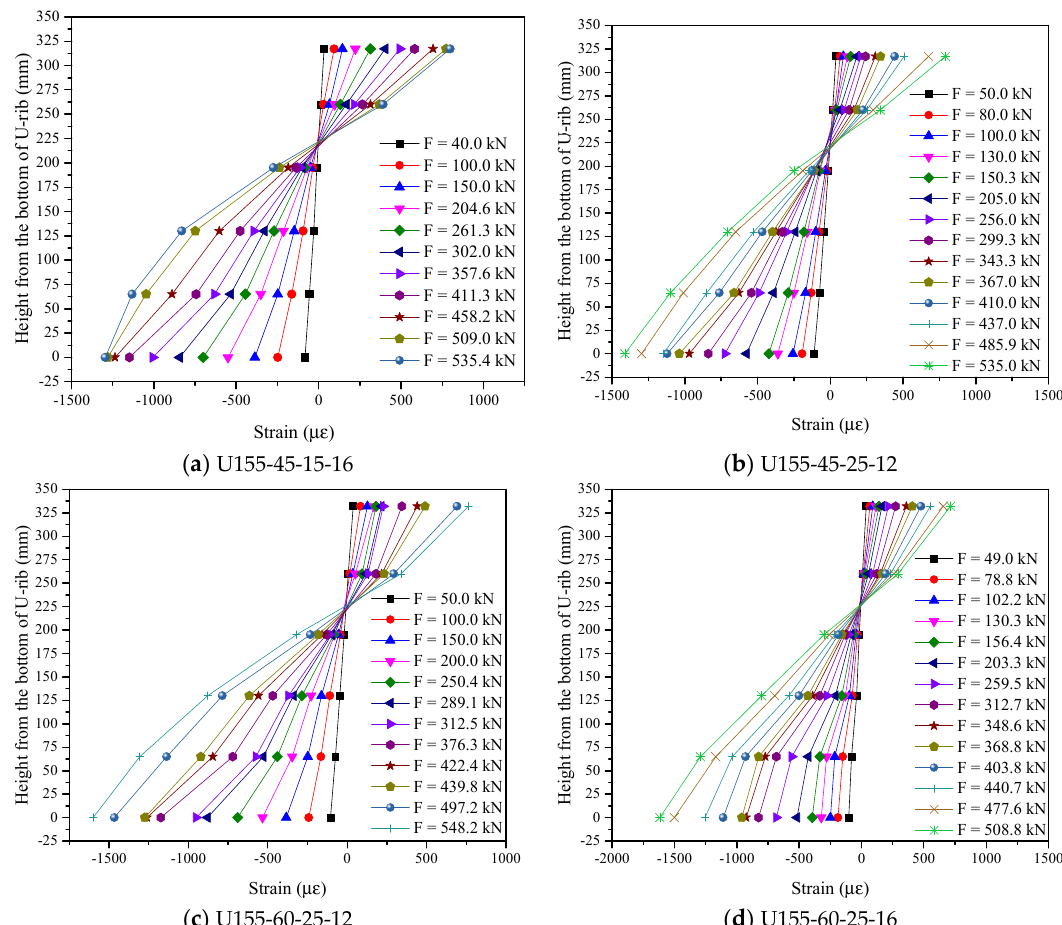
Figure 15. Strain distribution diagrams along the height direction.